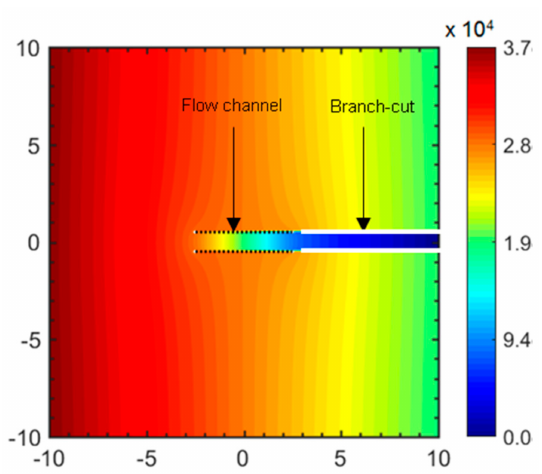
Figure A1. Pressure field for a far-field flow near a fracture. Length scale in m and pressure (rainbow colors) in psi.